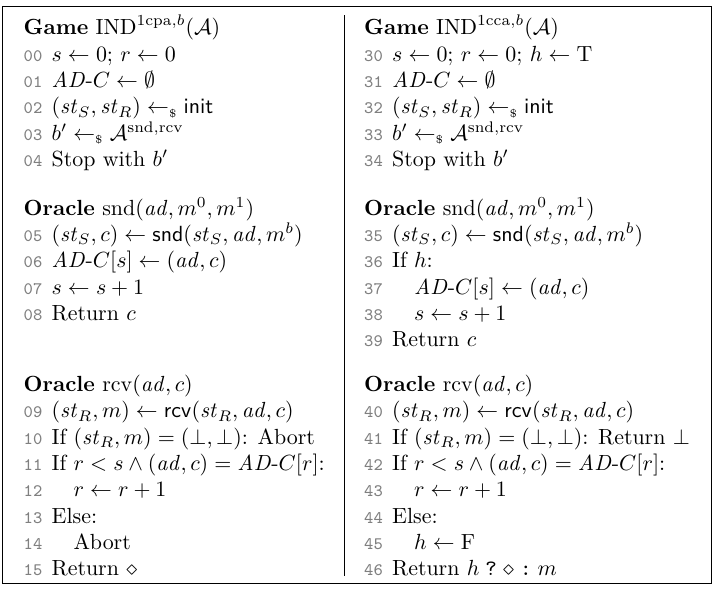
Figure 8: Games for confidentiality of unidirectional channels against chosen-plaintext (left) and chosen-ciphertext (right) attacks. (See also Figure 4 for an explanation of the notation.) Note the rcv oracle of game IND 1cpa is redundant and could be